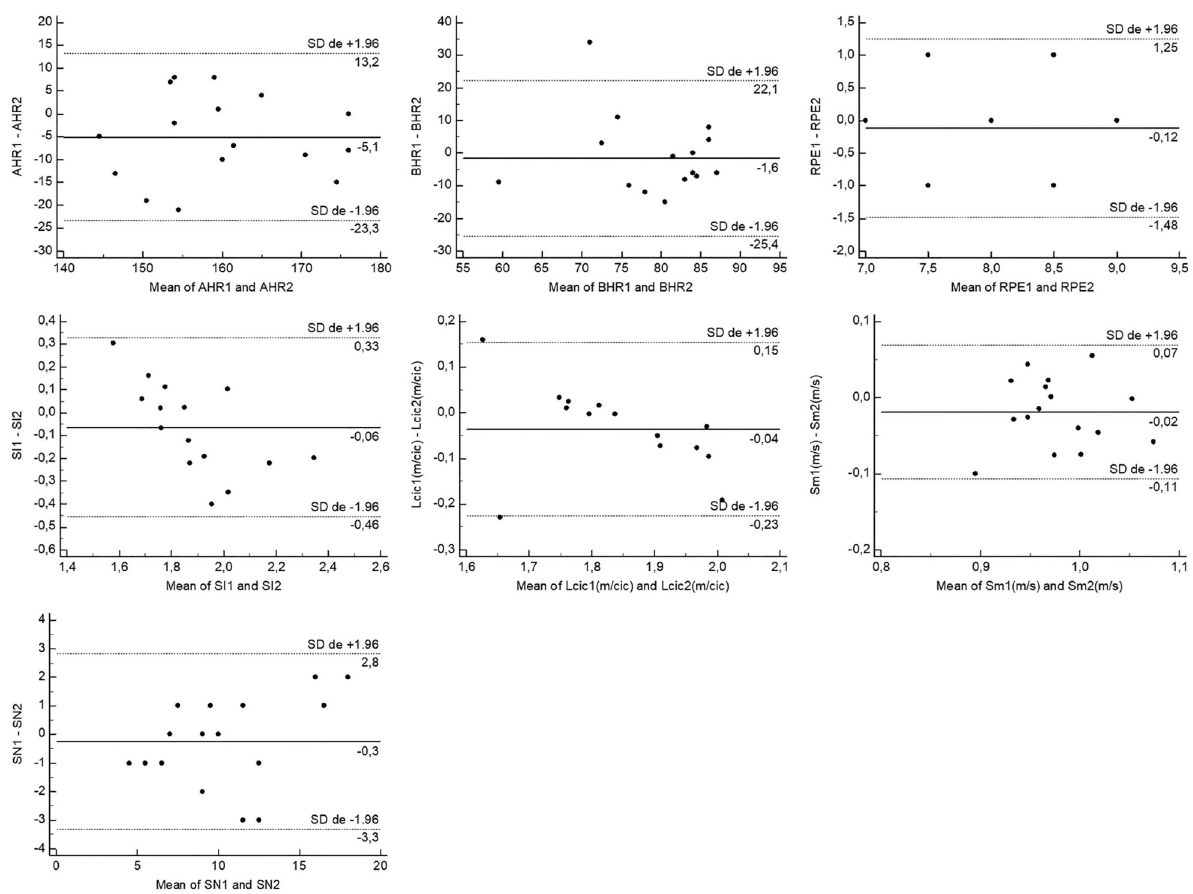
Figure 2 - Limits of intragroup agreement in master swimmers. BHR - before (test) heart rate in beats per minute; AHR - after (test) heart rate in beats per minute; SN - swimming number (laps); S m - Average speed in meters per second (average number of laps performed); L cic - stroke cycles length in meters per cycle (average number of laps performed); SI -